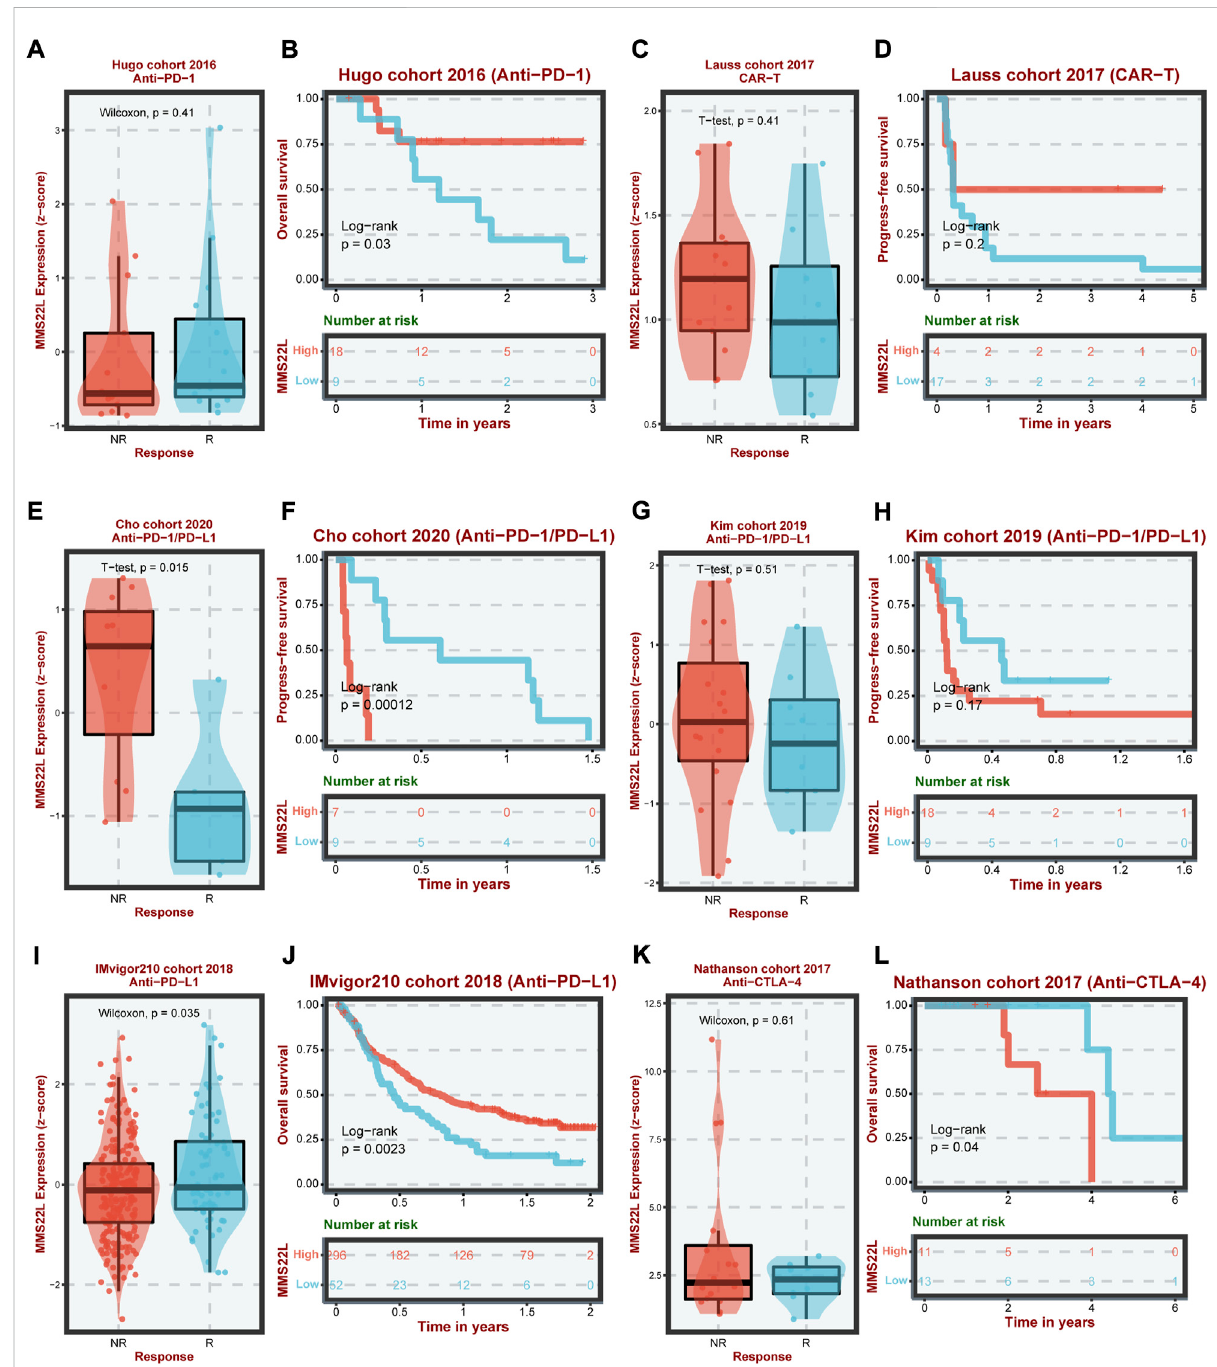
FIGURE 6 Analysis of methyl methanesulfonate-sensitivity protein 22-like (MMS22L) in cancer immunotherapy in different cohorts. The difference in MMS22Lexpressionbetweenthecorrespondinggroupandthenon-correspondinggroupanditsrelationshipwiththeprognosisofpatientsinHugo (A,B) , Lauss (C,D) , Cho (E,F) , Kim (G,H) , IMvigor210 (I,J) , and Nathanson (K,L)